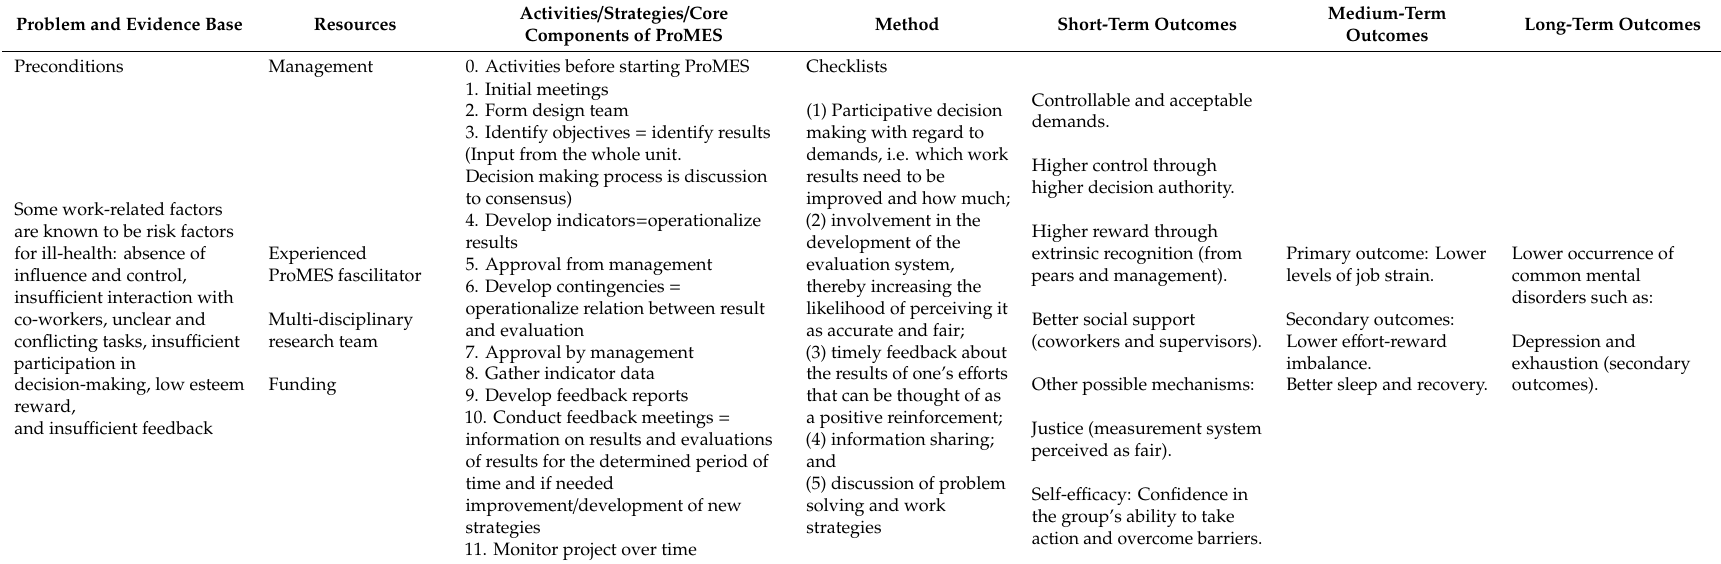
Table 1. Logic model of ProMES / Theory of